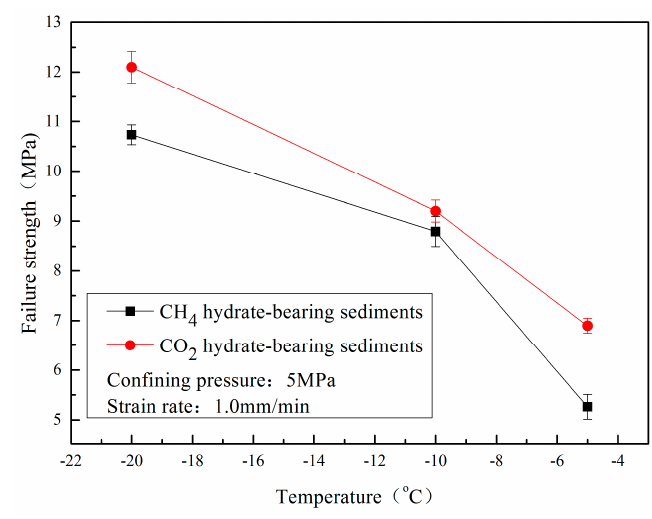
Figure 11. Failure strength of the CH 4 and CO 2 hydrate-bearing sediments under different temperatures.